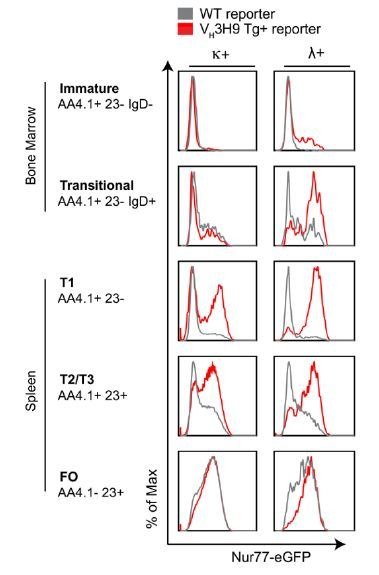
Self-reactive B cells upregulate Nur77-eGFP at early stages of B cell development.Nur77-eGFP BAC Tg was crossed to the Vh3H9 HC site directed Tg. BM and splenic cells from these mice (red) and unrestricted repertoire reporter mice (gray) were harvested and stained ex vivo to identify B cell subsets as well as surface light chain expression. Histograms depicting GFP expression in K+ and L+ B cells subsets are representative of > 9 biological replicates.